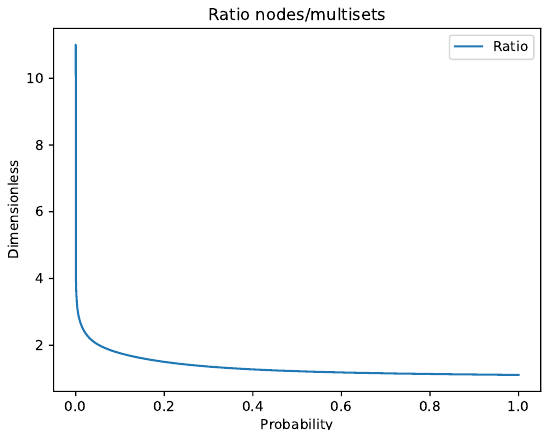
Figure 3. The ratio of “data overhead” derived from Figure 2, as the density p of our data structure increases. Unless we are in a very sparse setting, the trade-off in terms of space is